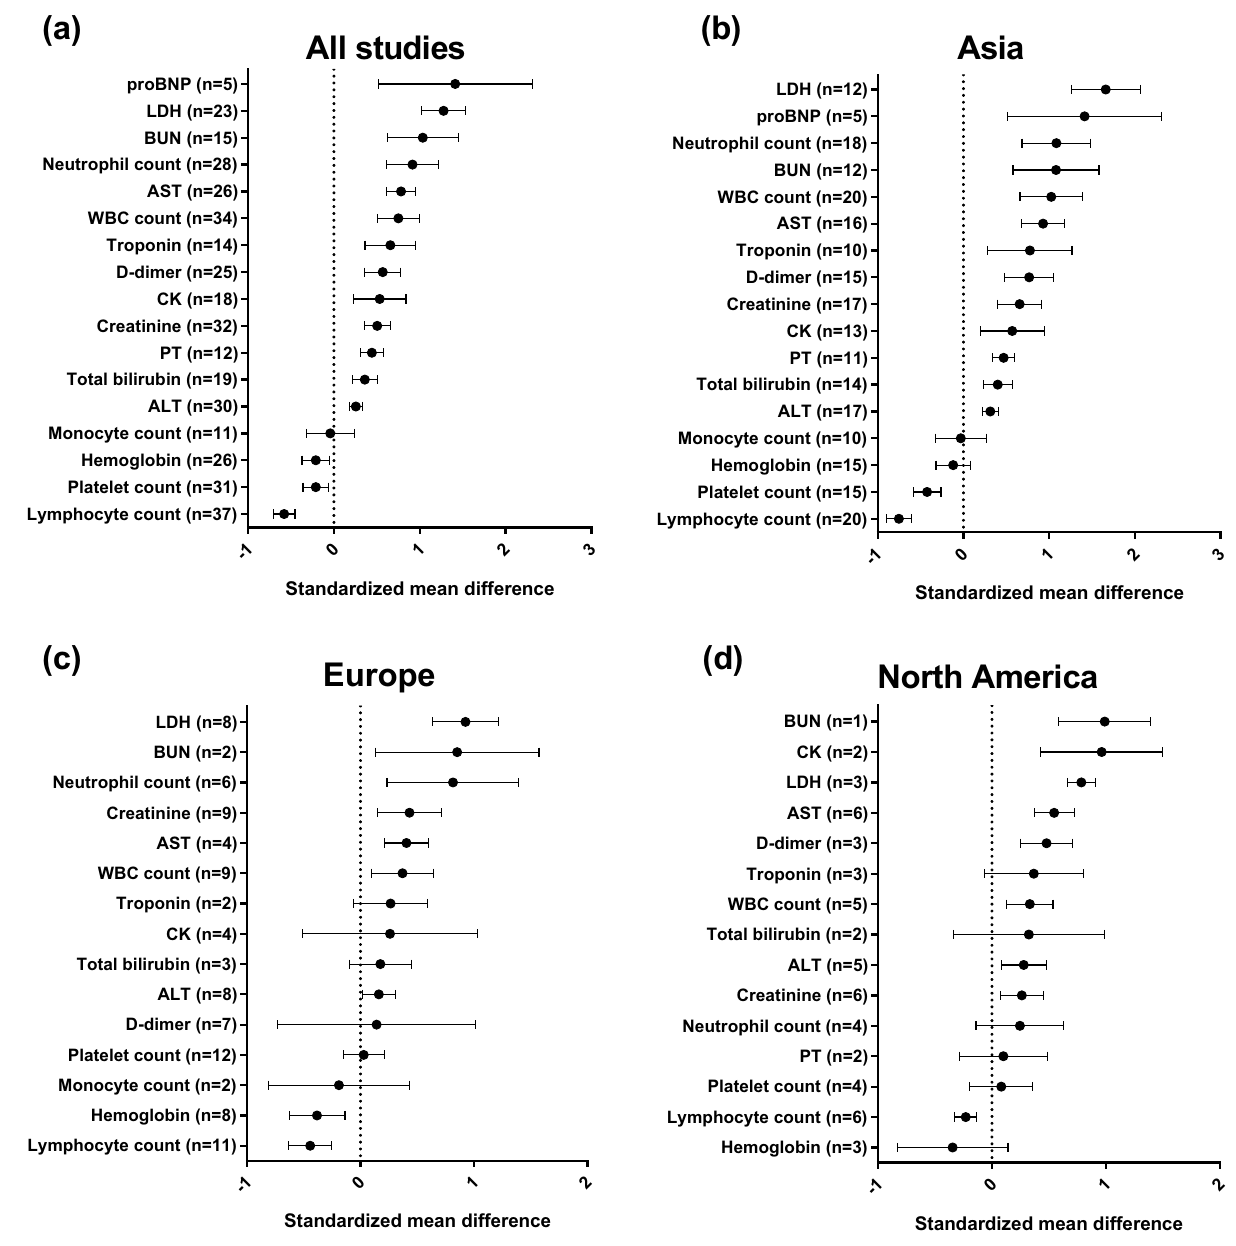
Figure 3. Associations between laboratory findings and the critical outcome of COVID-19. The numbers in parenthesis represent the number of studies included in the pooled analysis. ( a ) Pooled analysis of all included studies. ( b )–( d ) Pooled analyses of studies performed in Asia, Europe, and North America,